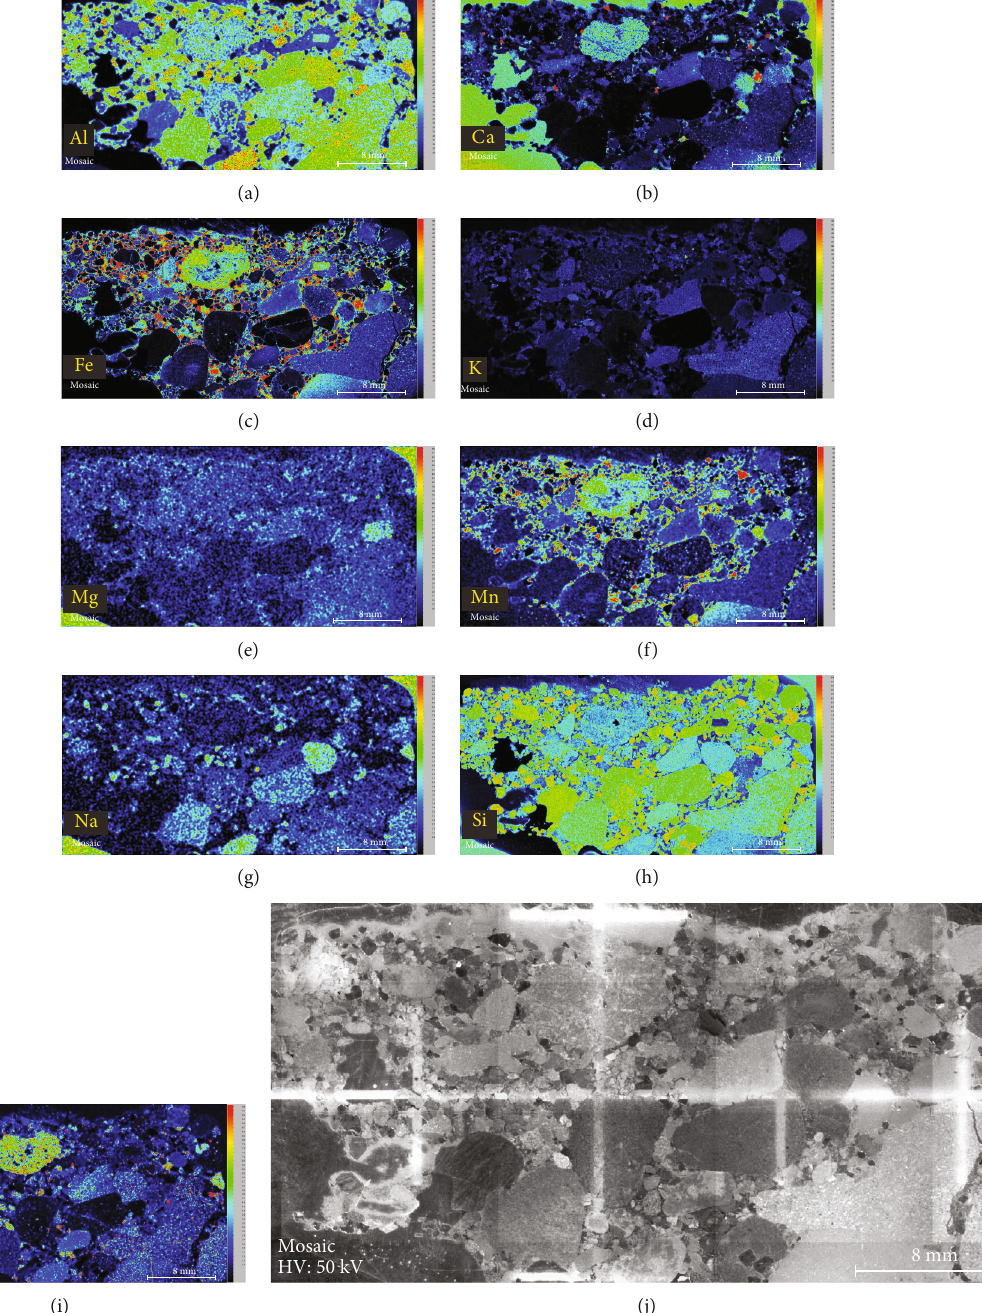
Figure 5: Element maps of a sample from well D5 obtained by XRF analysis. On the migration pathway, Al, Fe, Mn, and Ti are enriched and have been a ff ected by migration, indicative of strong fl uid-rock interactions. Q-1=core of the quartz grain; Q-2=quartz